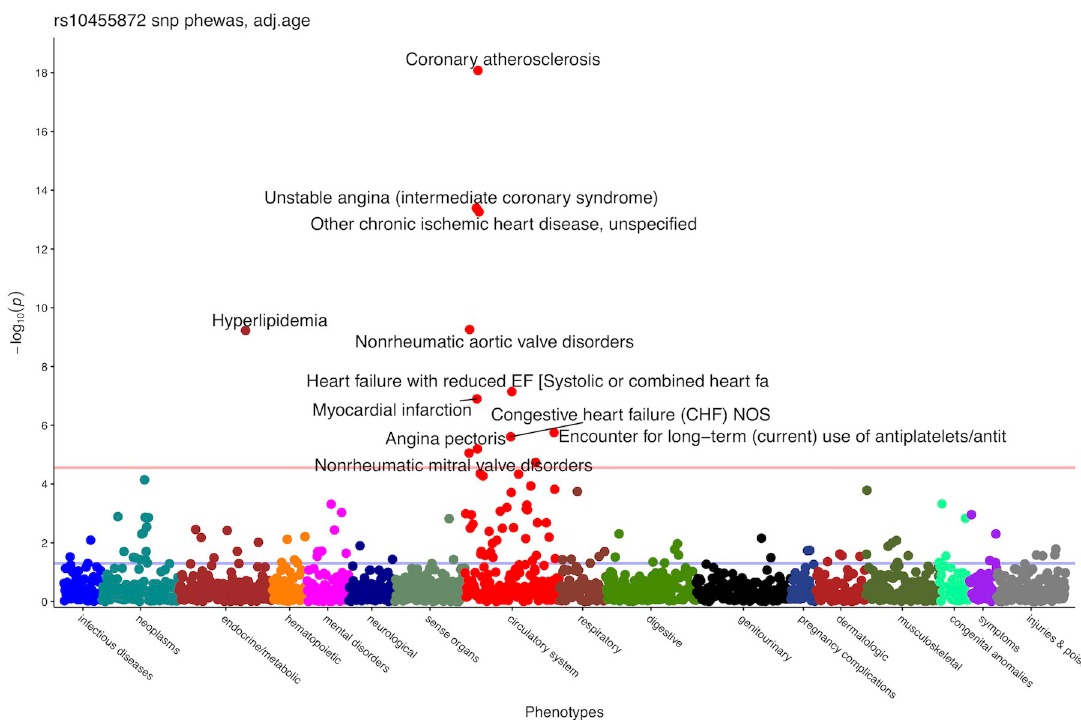
Fig 5. PheWAS results of rs10455872 on 12,759 individuals adjusted by sex and age.